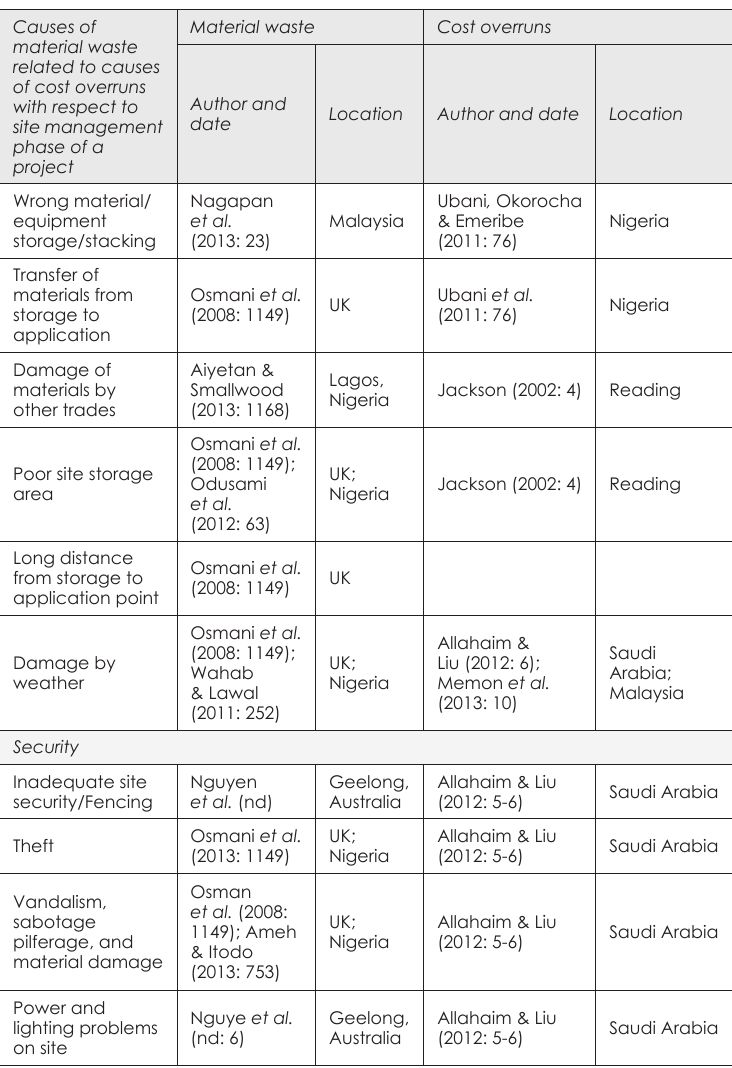
The relationship between the causes of material waste and cost overruns with respect to quality of site